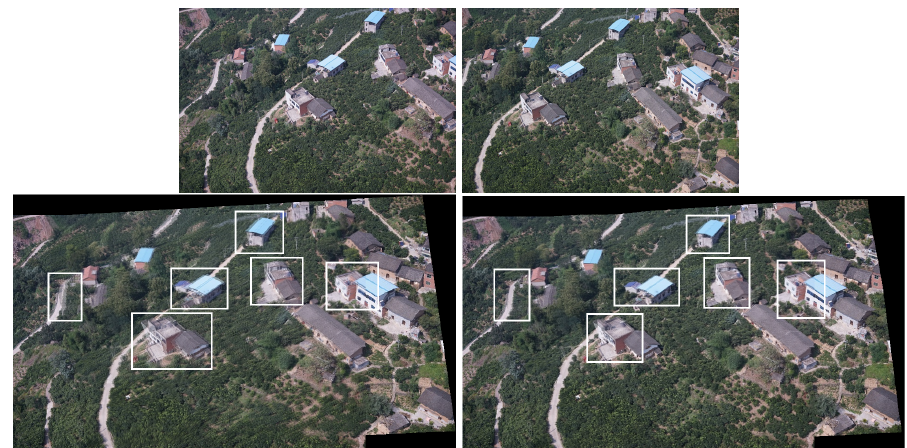
Figure 3. Mosaic results. The first row is the two images to be stitched together. The second row is two stitched images by global homography and local homography, respectively. White boxes highlight the ghostly parts.